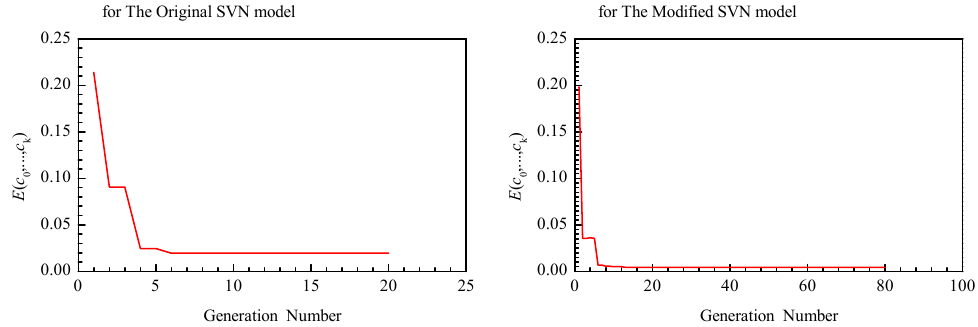
Figure 6. The decline trend of the best objective function value during the parameter calibration.